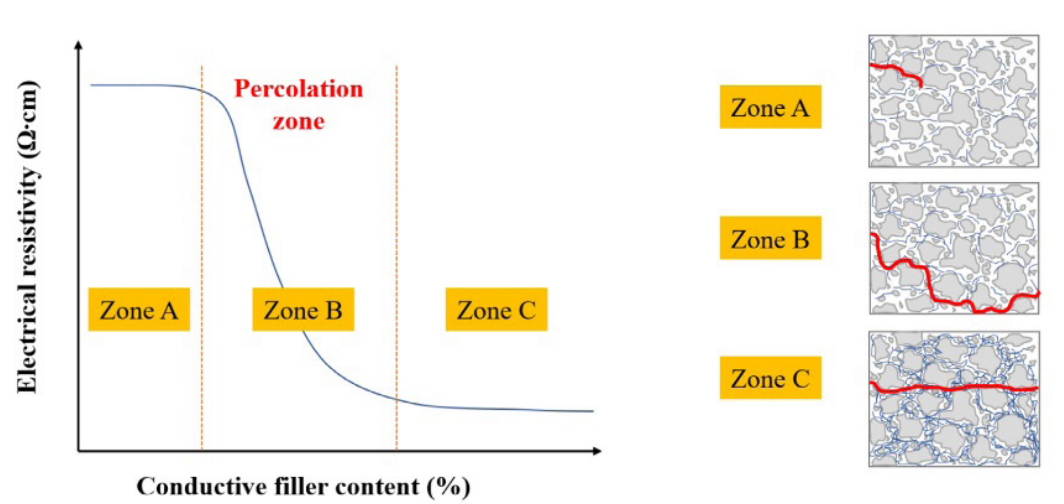
Figure 1. Schematic description of percolation theory. In Zone A, there is no conductive network. In Zone B, the resistivity is reduced abruptly, with few additions of fillers. Lastly, in Zone C, there is no significance in the reduction of resistivity when more fillers are added 22 .